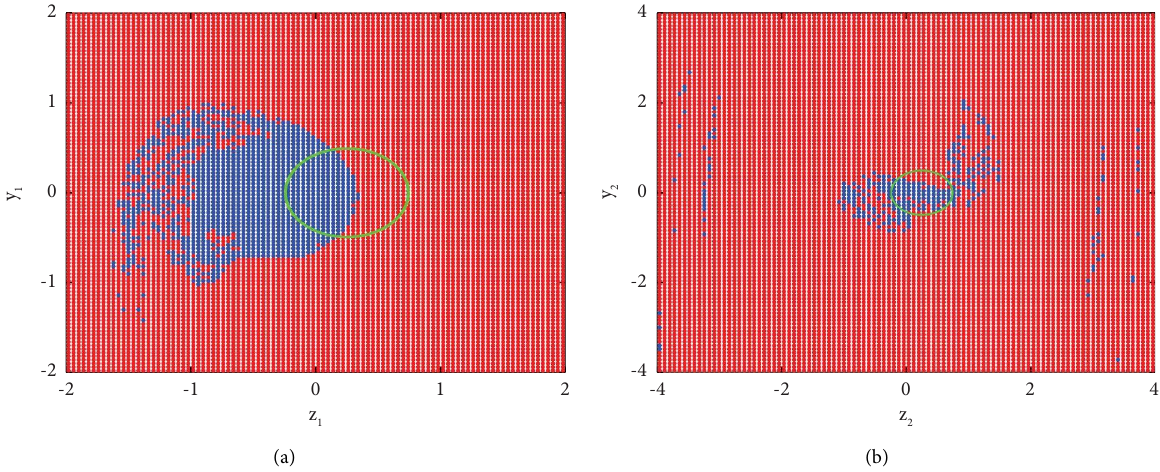
Figure 8: Te target orbit’s positions in the phase space. (a) Te z